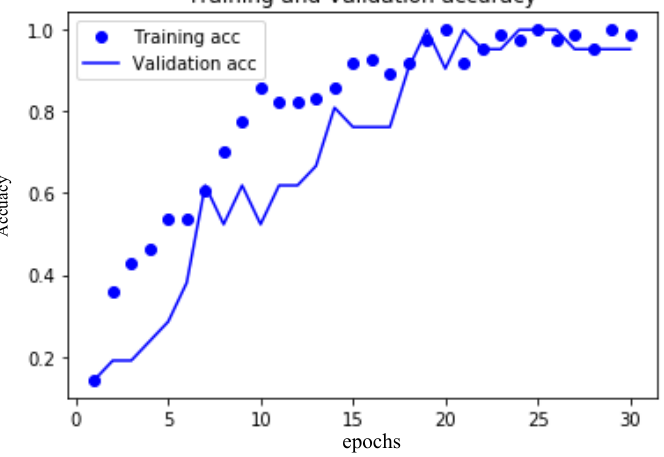
Figure 7. Accuracy of feature selection of PCA 8 epoch 30.